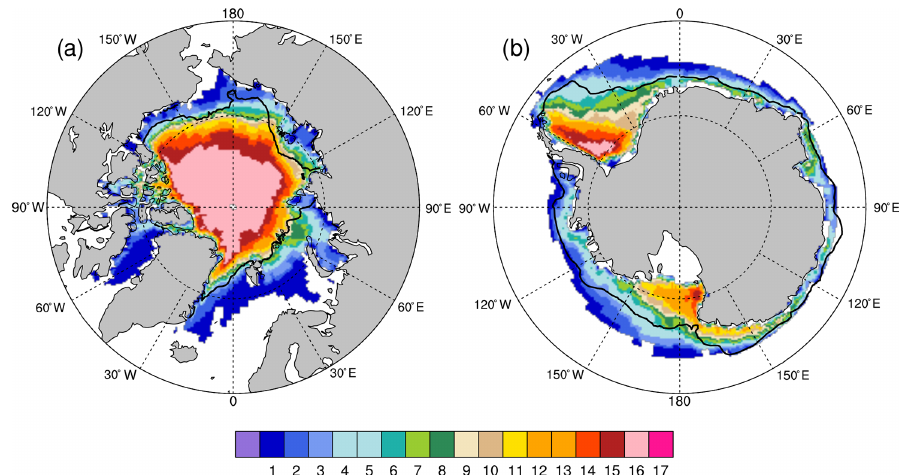
Figure 6. Comparison of the lig127k sea ice distributions (a) in the Northern Hemisphere for August–September and (b) in the Southern Hemisphere for February–March. For each 1 ◦ × 1 ◦ longitude–latitude grid cell, the figure indicates the number of models that simulate at least 15% of the area covered by sea ice. The average 15% concentration boundaries (black lines) are averaged for 2000–2018. See Figs. S3 and S5 for individual model results.